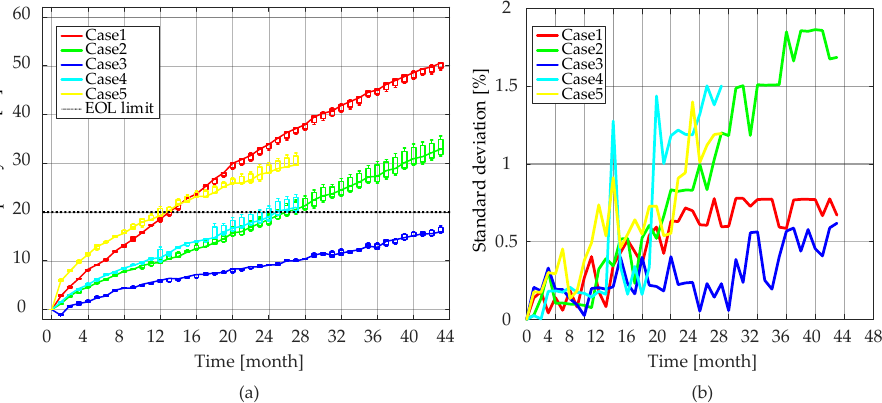
Figure 5. Capacity fade curves of calendar-aged cells under different conditions. ( a ) Boxplot of the capacity fade, ( b ) Standard deviation of the capacity fade.